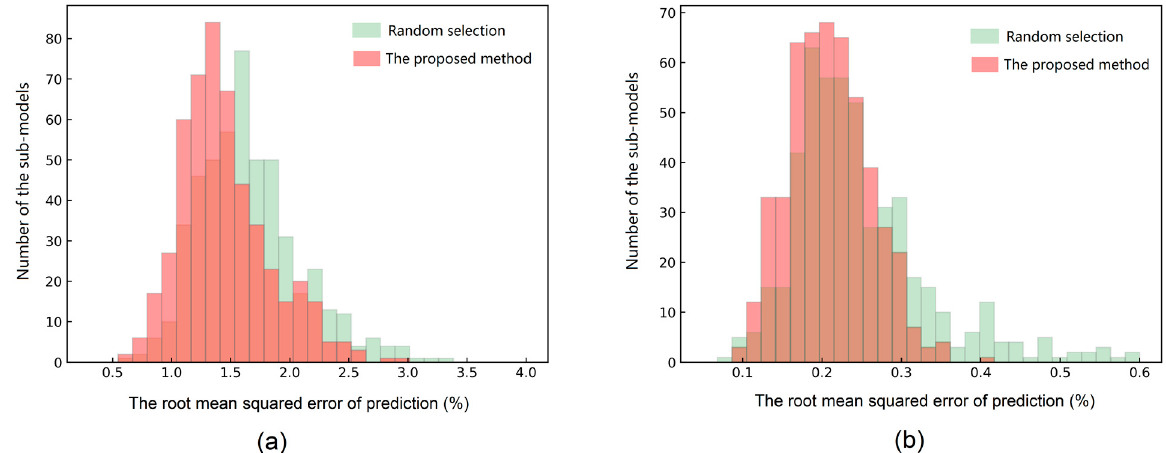
Figure 4. Statistical histograms of the sub-model prediction results obtained by the random selection strategy and the proposed wavelength selection method: ( a ) hydrolyzed leather protein (HLP) data set; ( b ) melamine data set.